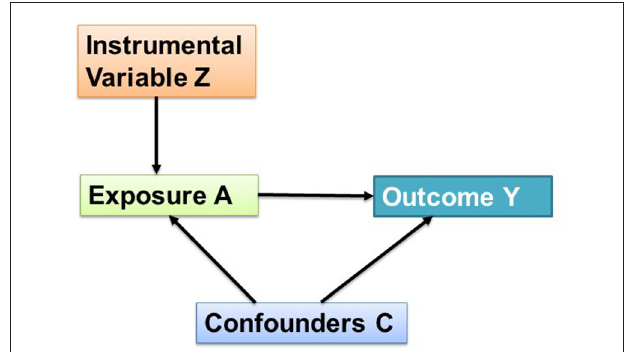
FIGURE 1 | Directed Acyclic Graph (DAG) illustrating an instrumental variable